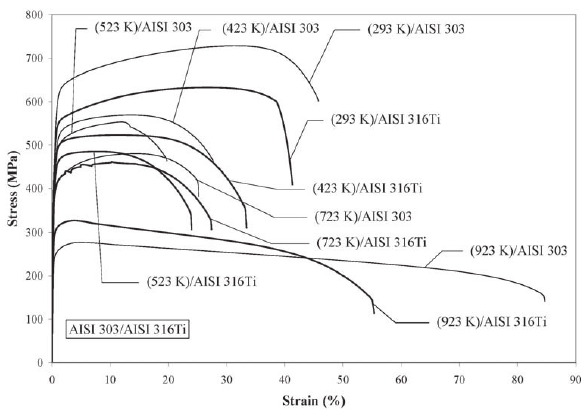
Figure 2. Engineering stress-strain diagrams of AISI 303 steel and AISI 316Ti steel at room and elevated tempera- tures.